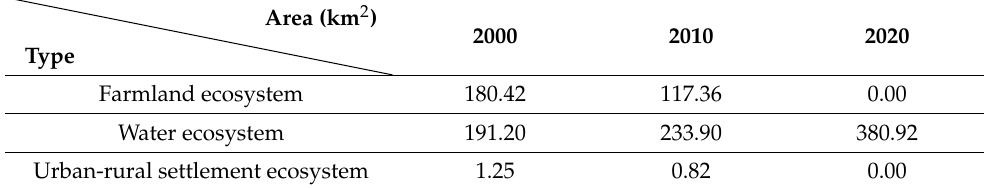
Figure 11. Annual change of water ecosystem area in Xichuan County from 2000 to 2020. Table 2. Distribution of ecosystem around Danjiangkou